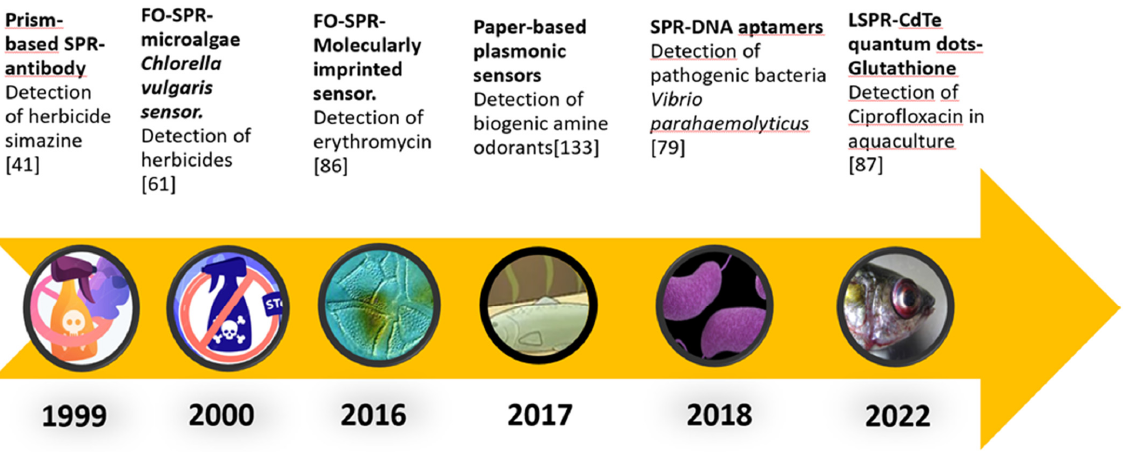
Figure 4. Roadmap of the implementation of plasmonic techniques and different recognition elements for their use in aquaculture.